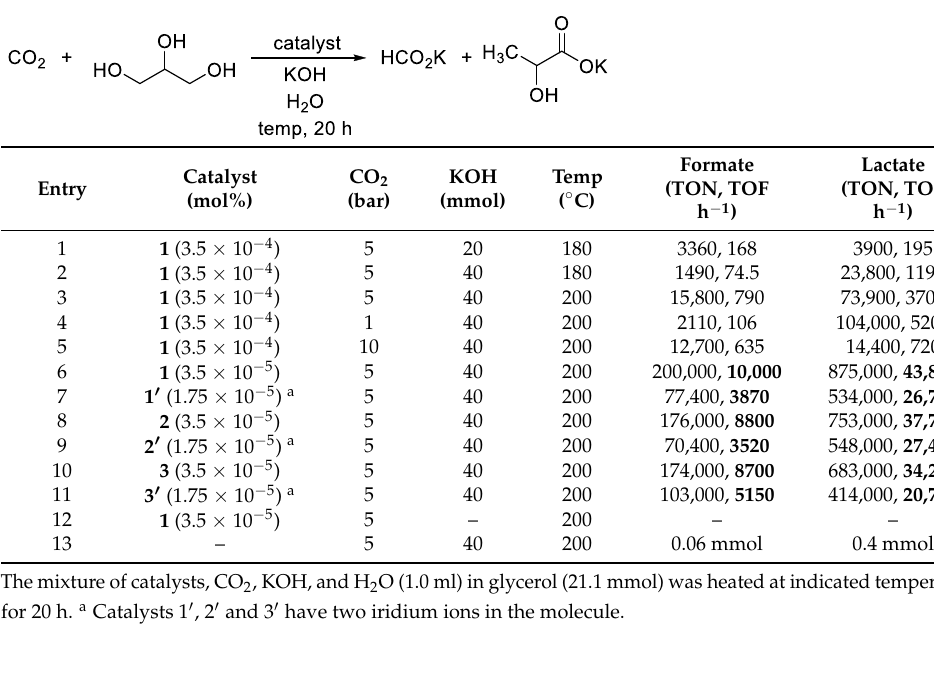
Figure 2. X-ray crystal structure of catalyst 3′ . For the transfer hydrogenation of K 2 CO 3 with glycerol, a mixture of catalyst 1 (3.5 × 10 −5 mol%), K 2 CO 3 (40 mmol), and glycerol (42.3 mmol) was heated at 200 °C for 20 h, producing formate and lactate with TONs of 203,000 and 414,000, respectively (Table 2, entry 1). Catalysts 1′ , 2 , 2′ , 3 , and 3′ were employed under the conditions of entry 1; the highest TONs and TOFs were achieved with catalyst 1 (Table 2, entries 1–6). Compared to the result of CO 2 and KOH, the TONs of formate are similar and the TONs of lactate are lower with K 2 CO 3 due to lesser basicity of K 2 CO 3 . The substituents at the carbene ligand or bi/monometallic structure of the catalysts did not make dramatic changes in TONs. The reaction of K 2 CO 3 in 1,2-propandiol formed formate with TONs of 38,000, which is lower than the reactions of glycerol.